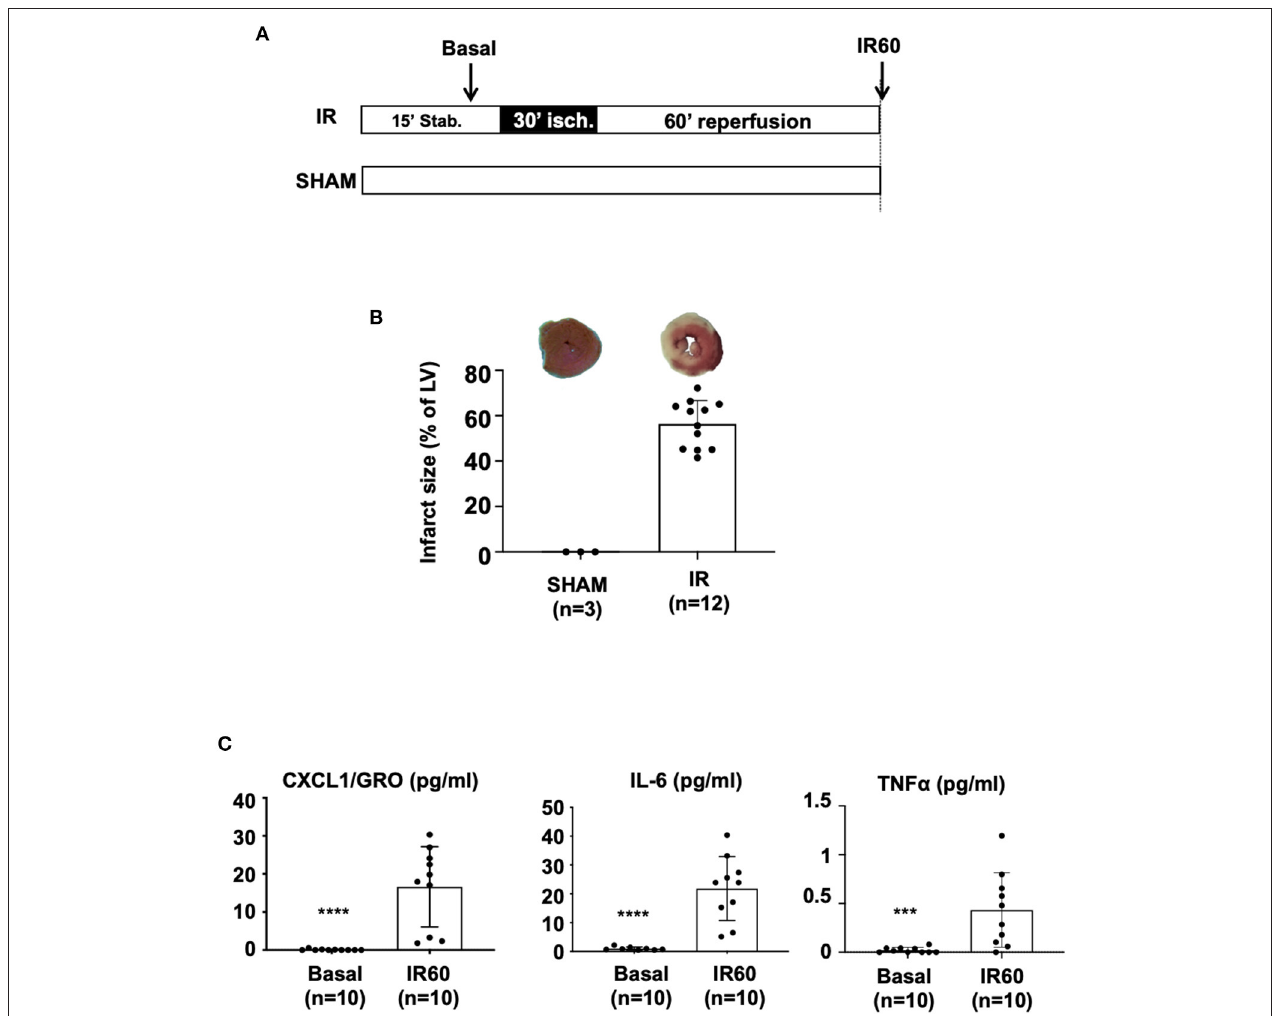
FIGURE 1 | C57BL/6J mouse hearts were mounted on a Langendorff system and subjected to IR injury. (A) The ex vivo protocol included a 15 min-stabilization period, followed by 30min of global ischemia achieved by stopping the flow in the aorta (no-flow). Reperfusion was achieved by restoring the Tyrode infusion during 60min. For the SHAM condition, the heart was perfused throughout the protocol without any ischemic induction. At the end of the protocol, infarct size was measured using the TTC-staining method. Coronary effluents were collected at two time points during the ex vivo protocol: during stabilization to evaluate the “basal” level of cytokine release and at the end of the reperfusion phase to evaluate the “IR60” cytokine production after IR injury. (B) Scatter plots and bars (mean ± SD) were represented for infarct size (in % of LV) in IR ( n = 12) and SHAM ( n = 3) hearts. Representative pictures of TTC-stained LV slices were shown for each group. (C) Scatter plots with bars (mean ± SD) are presented for quantification of cytokines within coronary effluents collected before ischemia (Basal) and after 60min of reperfusion after the IR protocol (IR 60 ) using the Meso Scale Discovery (MSD) V-Plex Plus Proinflammatory Panel 1 (mouse) kit. Statistical analysis was performed using the Mann-Whitney test. For CXCL1 (pg/ml), **** was noted for p < 0.0001, for IL-6 (pg/ml), **** was noted for p < 0.0001 and for TNF α (pg/ml), *** was noted for p =